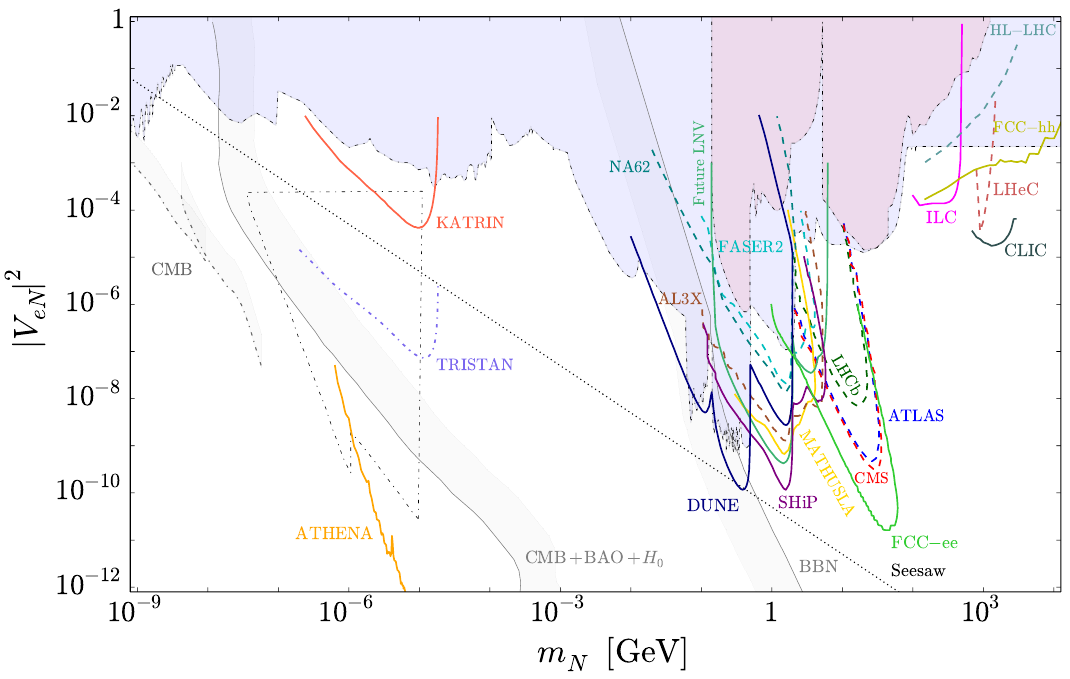
Figure 7 . As (cid:12)gure 6, but showing the expected sensitivity of future searches and observations. The shaded blue region indicates the parameter space already excluded from current searches as detailed in (cid:12)gure 6. The shaded red region contained therein further details current limits from searches for LNV